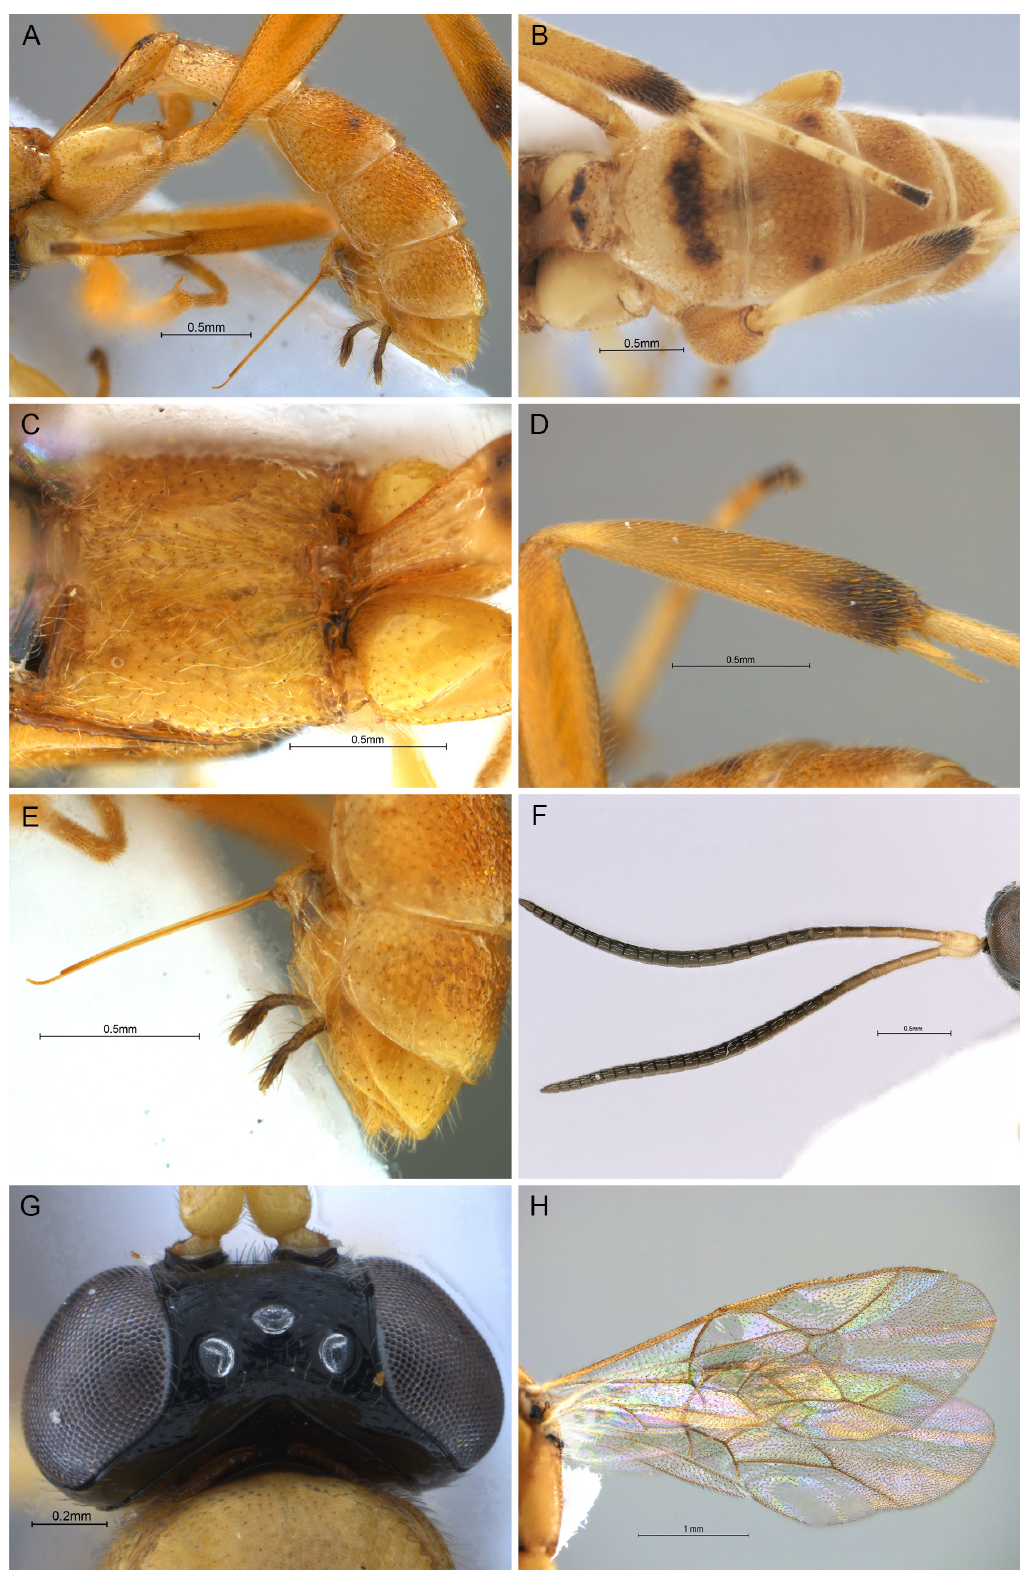
Fig. 10. Palpostilpnus hainanensis sp. nov., holotype, ♀ (SCAU). A–B . Metasoma, lateral and dorsal views. C . Propodeum, dorsal view. D . Hind leg. E . Ovipositor. F . Antennae. G . Vertex. H .